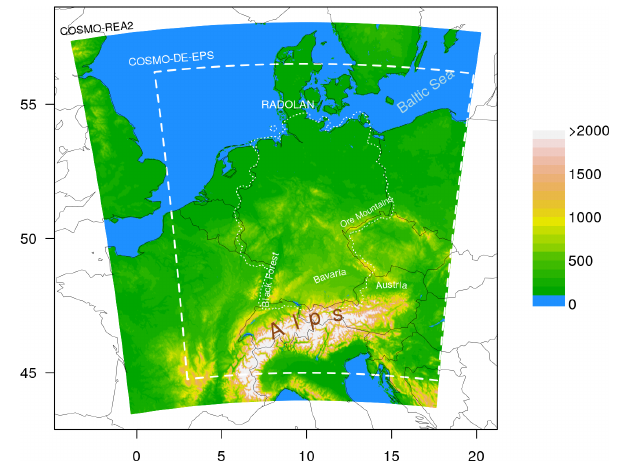
Figure 1. Domain and model orography of COSMO-REA2 in me- tres. Dashed lines delineate the COSMO-DE-EPS domain, and the dotted line corresponds to the maximum extent of the RADOLAN- RW data set used in this